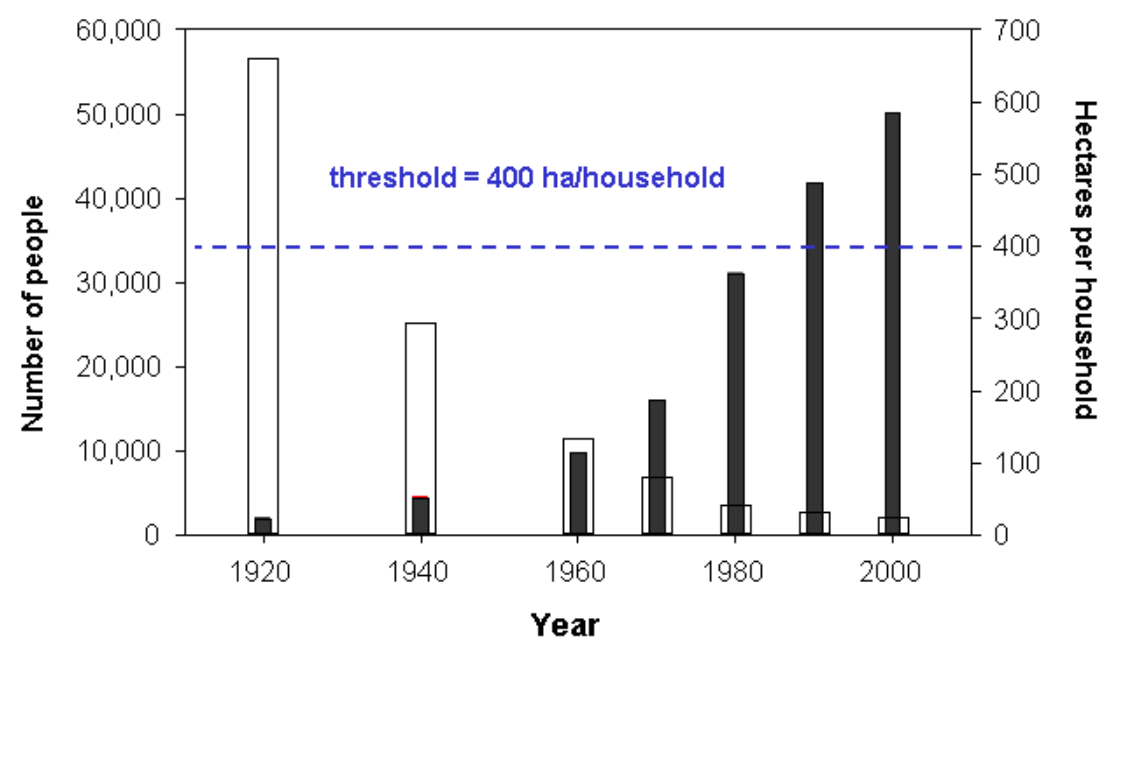
Fig. 5 . Changes in the human population and the area available per household in the Matibi II Communal Land in South Eastern Zimbabwe. With minimal external inputs, a household requires 20 ha of arable land, i.e., 4 ha with a minimum 5-yr rotation, and about 400 ha of grazing land to support a herd of 25 head of cattle and 35 goats. The threshold of 400 ha per household was reached during the 1940s. Filled bars indicate the number of people in the area (left-hand y-axis); empty bars indicate available area for farming (right-hand y-axis). Figure after Cumming